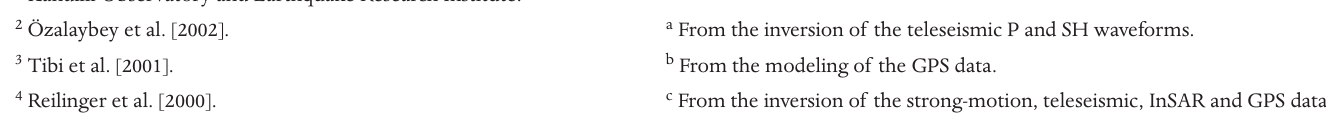
Table 1. The hypocentral and source parameters of the August 17, 1999, İ zmit earthquake estimated by different seismological organizations and previous